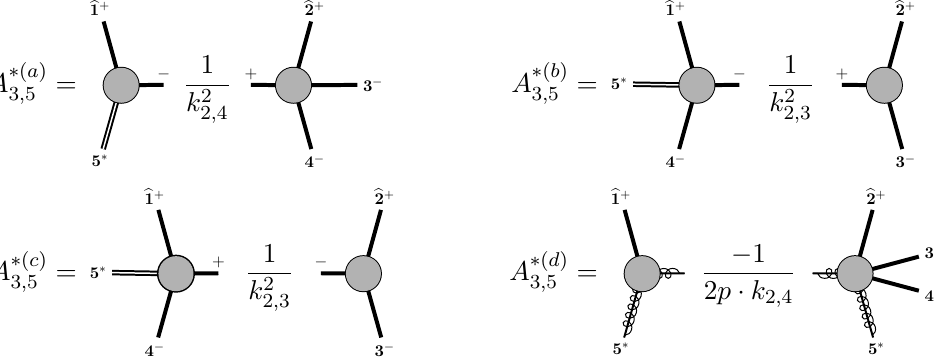
Figure 3 . BCFW contributions for A (cid:3)